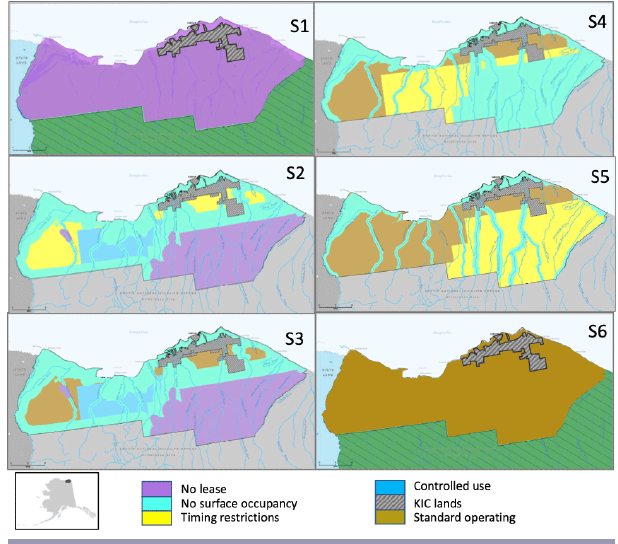
Fig. 3 . The percent of days, while on 1002 area, collared caribou would spend in specific proposed lease stipulation areas for six development alternatives. “KIC” is Kaktovik Inupiat Land, native village corporation holdings within 1002 lands. Details of other stipulation areas explained in